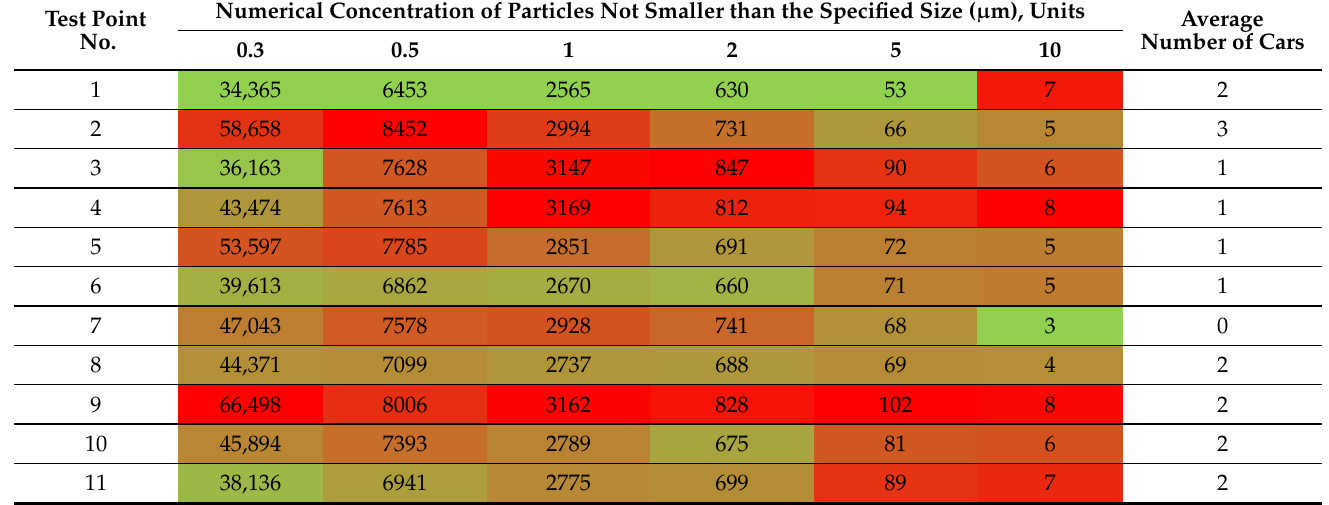
Table 4. The mean numerical concentrations of particulate matter at a height of 1.5 m in zone A. Test Point